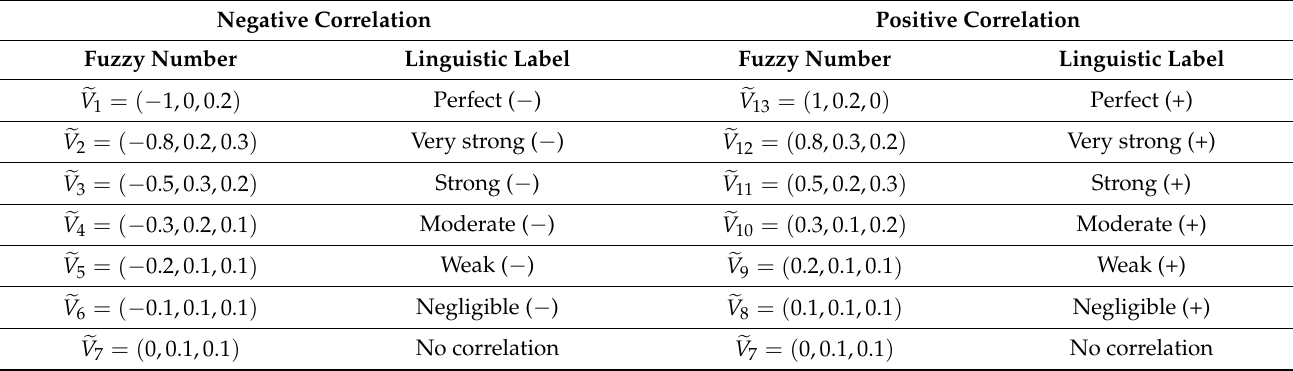
Negligible ( − ) No correlation No